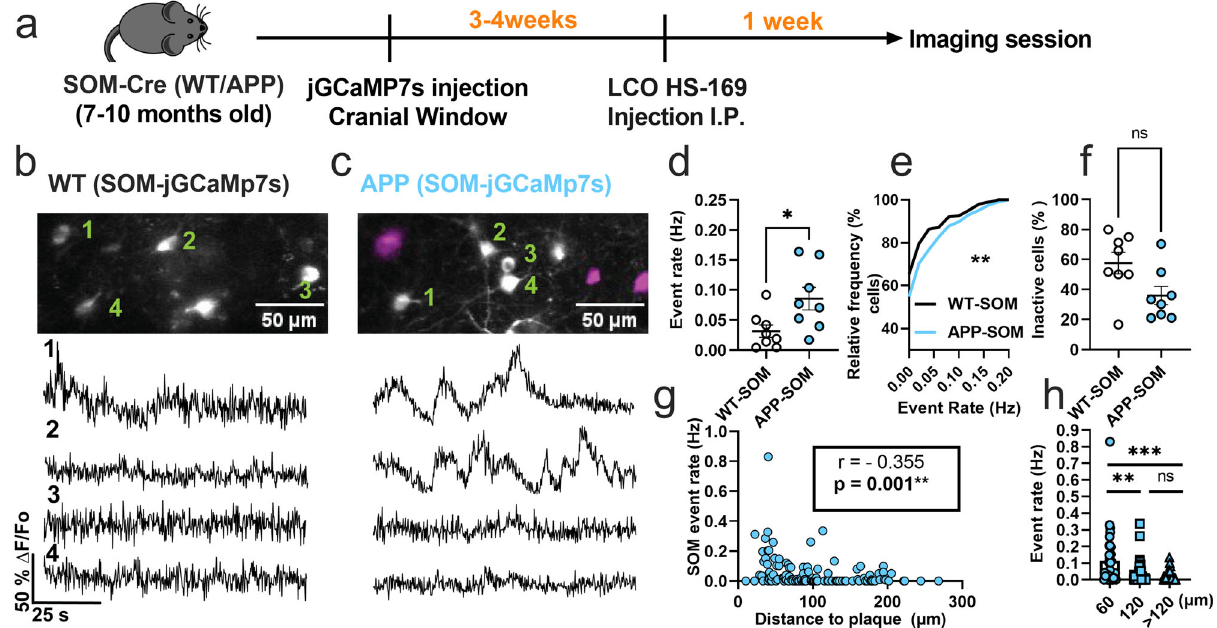
Fig. 1 SOM interneurons are hyperactive in APP/PS1 mice relative to WT mice. a Timeline of the experimental procedures. b , c Top, in vivo two-photon fl uorescence images of jGCaMP7s (grey) in SOM expressing interneurons in layer 2/3 of the somatosensory cortex from WT ( b ) and APP/PS1 ( c ) mice. Amyloid plaques were labeled with LCO-HS-169 (magenta); Scale bars, 50 μ m. Bottom, representative normalized fl uorescence traces of SOM interneurons activity from control ( b ) and APP/PS1 ( c ) mice. Representative images were created by averaging 500 images from SOM interneuron recordings at 256×256 resolution with green numerical labels to the right of each representative cell. d Mean neuronal activity rates as determined by counting the rate of deconvolved Ca + 2 events (Mann – Whitney U = 11, p = 0.024, two-tailed, n = 8 WT-SOM mice; 8 APP-SOM mice). e Cumulative frequency distribution of event rates in all imaged neurons (KS-test:D = 0.152, p = 0.0044, n = 210 WT-SOM neurons; 364 APP-SOM neurons). f Quanti fi cation of the fraction of inactive cells in APP-SOM mice relative to WT_SOM (Mann – Whitney U = 14, p = 0.06, two-tailed, n = 8 WT-SOM mice; 8 APP-SOM mice). g Correlations between event rates and the distance to amyloid plaque center in SOM interneurons (Spearman correlation: r = − 0.355, p < 0.0001. h Quanti fi cation of pooled event rates as a function of distance to amyloid plaque. Neurons were pooled into three groups (124) depending on their distance to amyloid plaque: <60 µ m, 60 – 120 µ m, and >120 µ m (Kruskal – Wallis test, H (2) = 18.41, p < 0.0001). Post hoc multiple comparisons were p = 0.0028 for SOM event rates <60 µ m vs. SOM < 120 µ m and p = 0.0001 for SOM event rates <60 µ m vs. rates >120 µ m and not signi fi cant, p = 0.715, for SOM event rates <120 µ m vs. rates >120 µ m. Each solid circle in d , f represents an individual animal, while each circle in g , h represents an individual neuron. All error bars re fl ect the mean ± s.e.m. Asterisks denote statistically si g ni fi cant differences (** p <